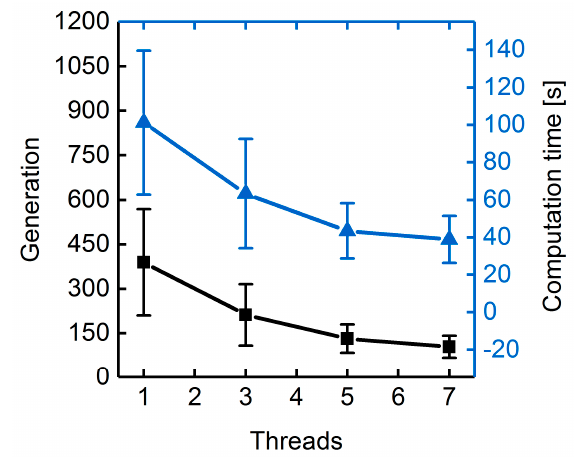
Figure 6. Number of generations (squares) and computation time (triangles) until maximal fitness was reached. Deletion of maximally seven reactions were allowed. Succinate BPCY was used as the engineering objective. Error bars denote the standard deviation of five replicate GA runs using one, three, five, and seven parallel threads.